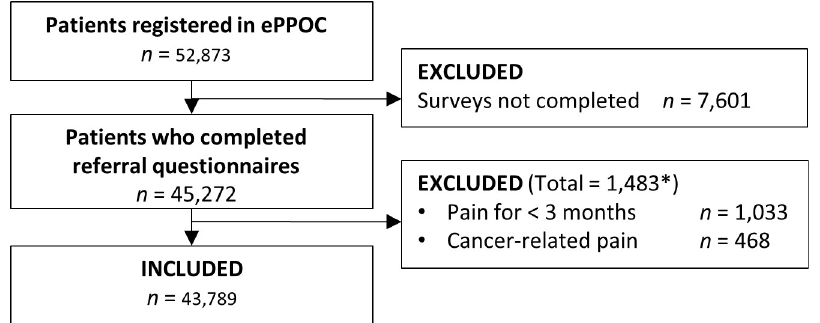
Fig 1. STROBE recruitment chart. Notes : 18 patients met multiple exclusion criteria ( � ). Age: mean = 52.17 years, SD = 15.59.